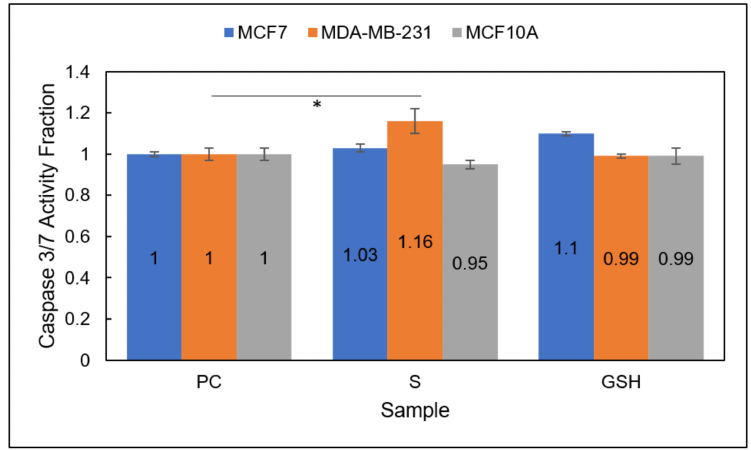
Figure 10. Caspase 3/7 activity fraction of NO (Group 1)-treated MCF7 (blue), MDA-MB-231 (orange), and MCF10A (gray) cells. Sample groups include: untreated PC cells, S (Group 1) cells, and GSH- treated cells. Data points represent the mean ± standard deviation. Statistically different values from the control are represented by * p < 0.05.